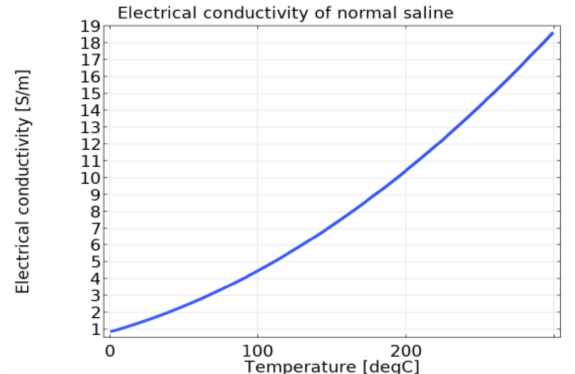
Figure 3. The electrical conductivity of saline as a function of